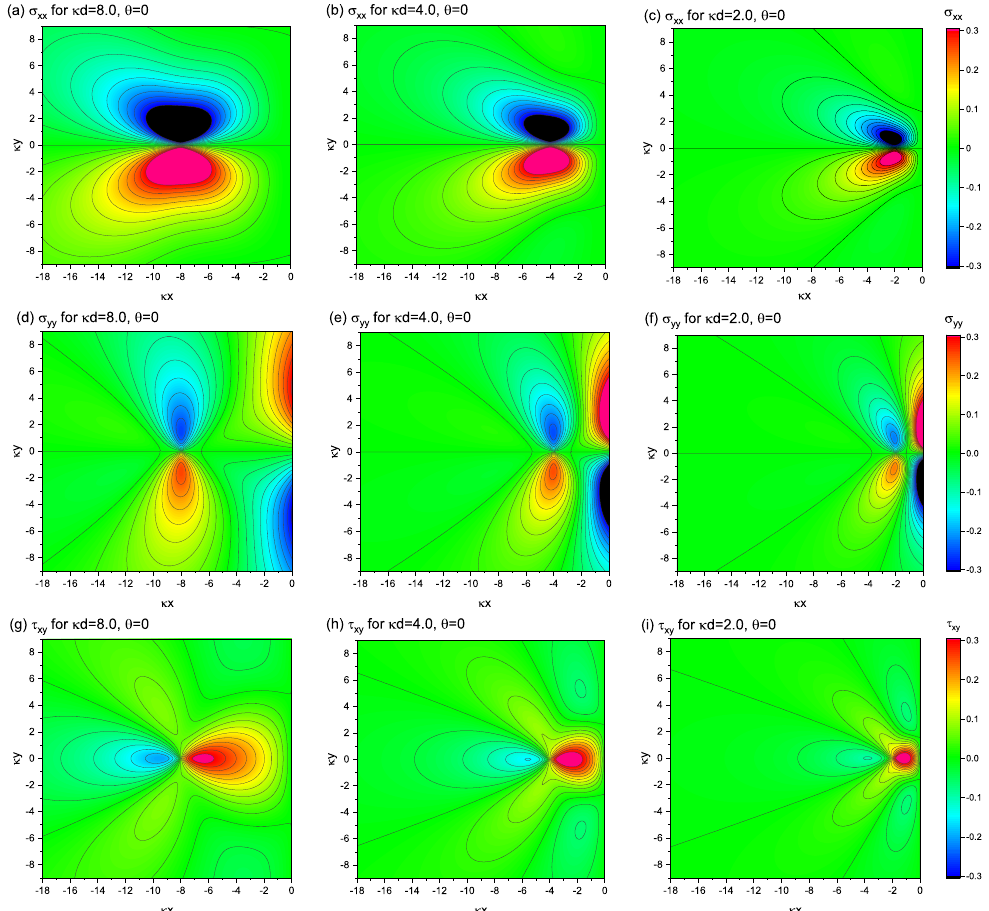
Figure 2. Nonsingular stress fields around a single edge dislocation positioned at ( x , y ) = ( − d ,0 ) with various values of d . For all the plots, θ = 0 is fixed, indicating that the Burgers vector of the dislo- cation is assumed to be parallel to the x -axis. Upper row: ( a – c ) σ xx ( x , y ) . Middle row: ( d – f ) σ yy ( x , y ) . Bottom row: ( g – i ) τ xy ( x , y ) . The units of stress and length scales are set to be µκ b /2 ( 1 − ν ∗ ) and κ − 1 ,